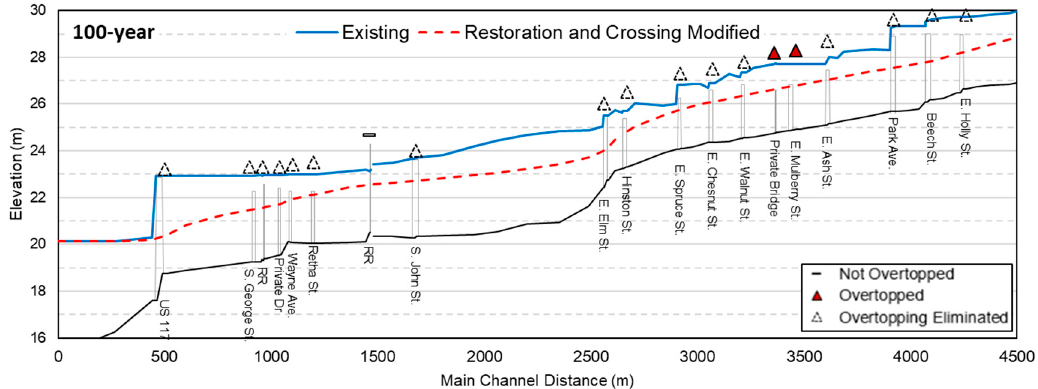
Figure 9. Water surface profiles for the Existing Condition and the Restoration and Crossing Modified scenario for the 100-year event.